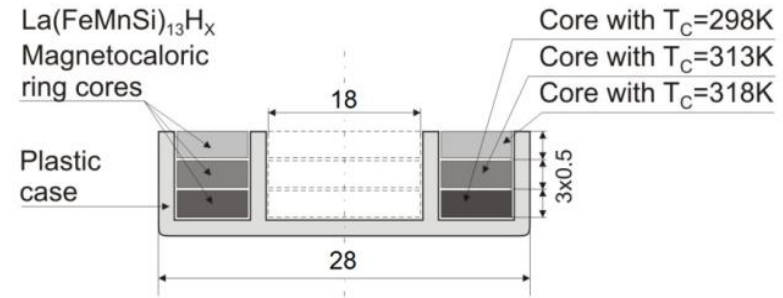
Figure 2. Schematic cross-section of the sandwich sample made of three rings exhibiting di ff erent Curie temperatures.